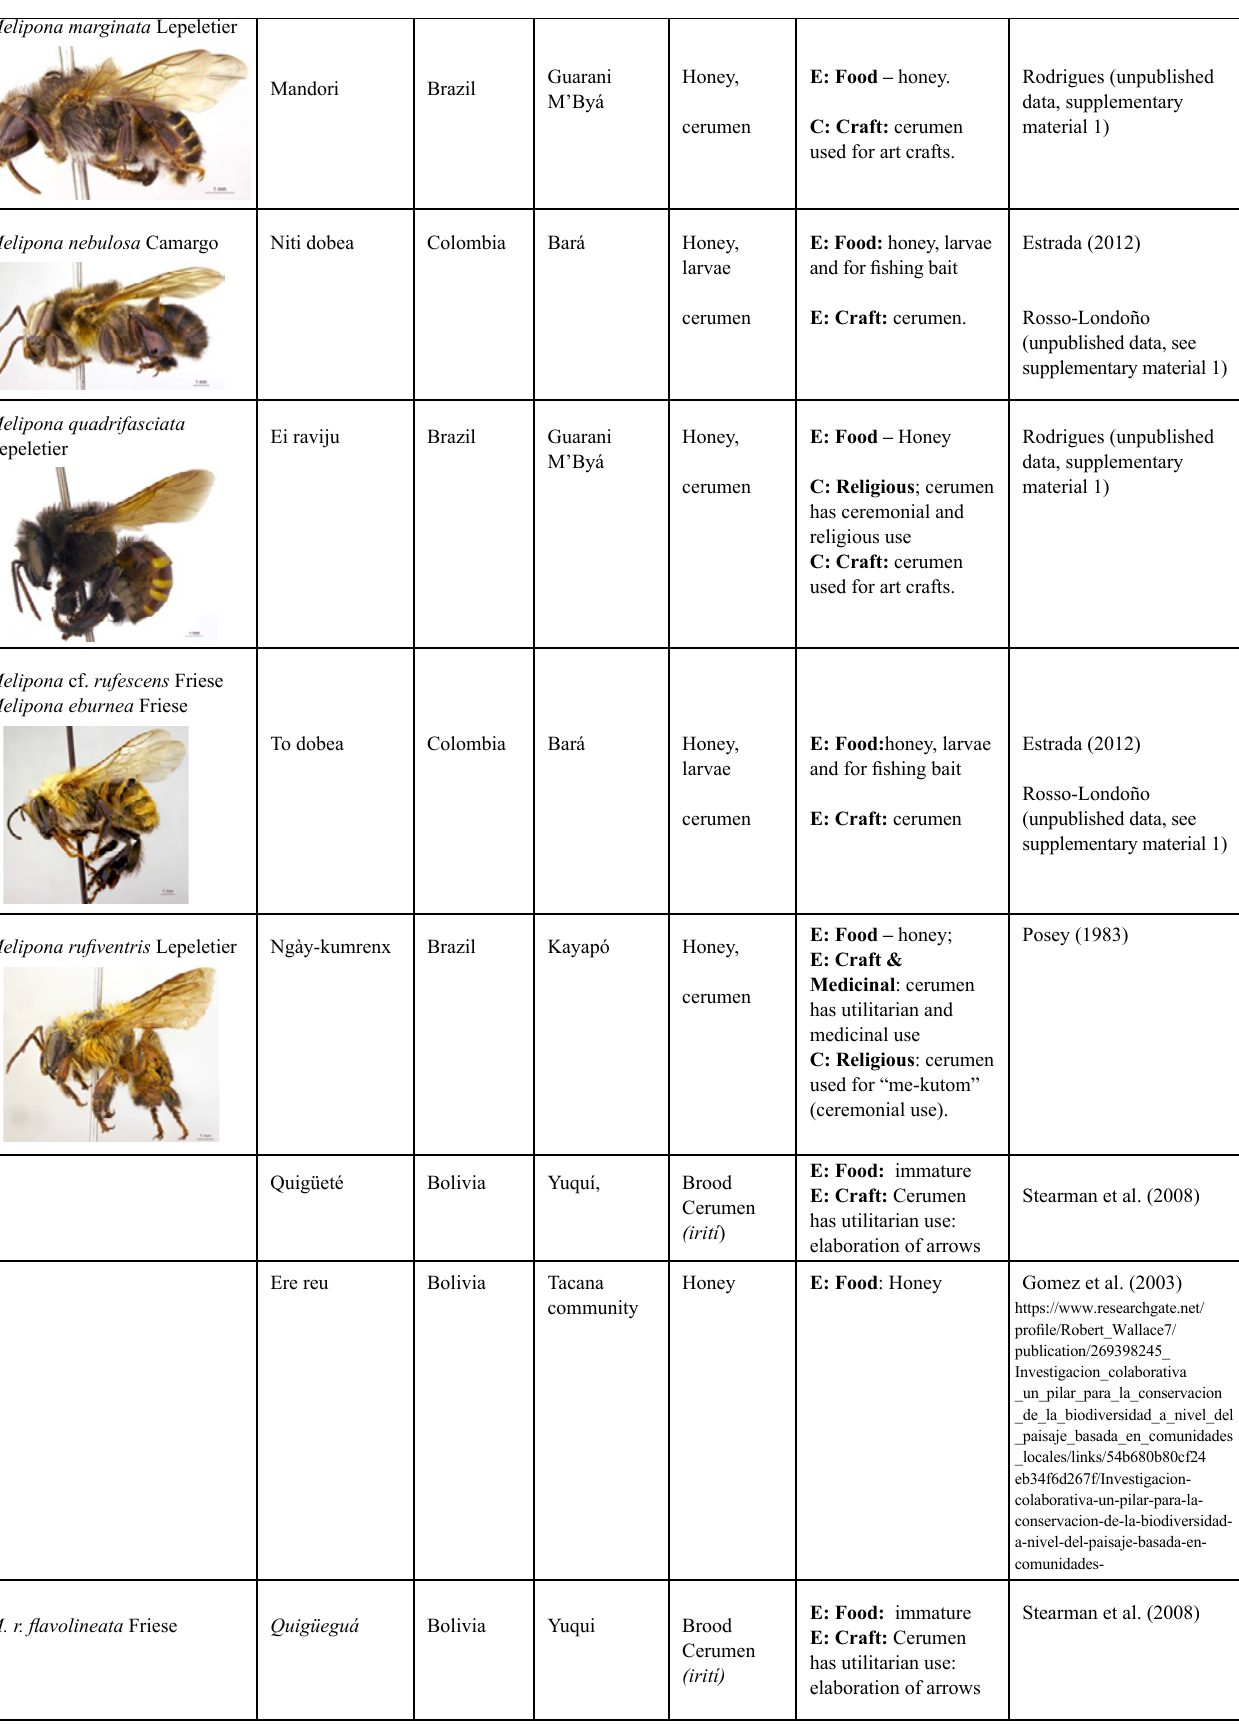
Table 1 . Economic and cultural values associated with stingless bees by different ethnic groups of tropical America.